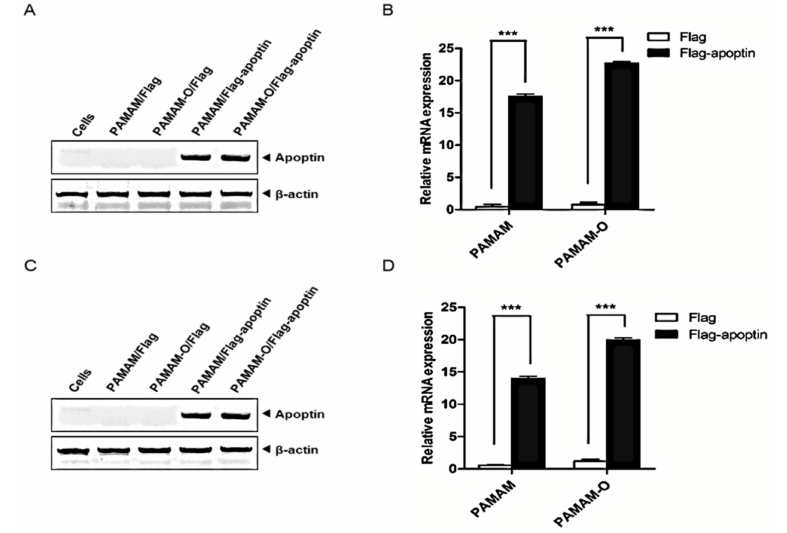
Figure 5. Apoptin gene expression of the PAMAM-O dendrimer. HepG2 cells ( A ) and dermal fibroblasts ( C ) were transfected with polyplexes of PAMAM and PAMAM-O dendrimers and 1 µ g of Flag or Flag-apoptin (polymer:DNA = 8:1). At 24 h post transfection, apoptin gene expression was analyzed using RT-PCR ( A , C ) and q-PCR analysis ( B , D ). Data represent mean ± standard deviation ( n = 3). Asterisks show statistical significance. Unpaired t -test: *** p <